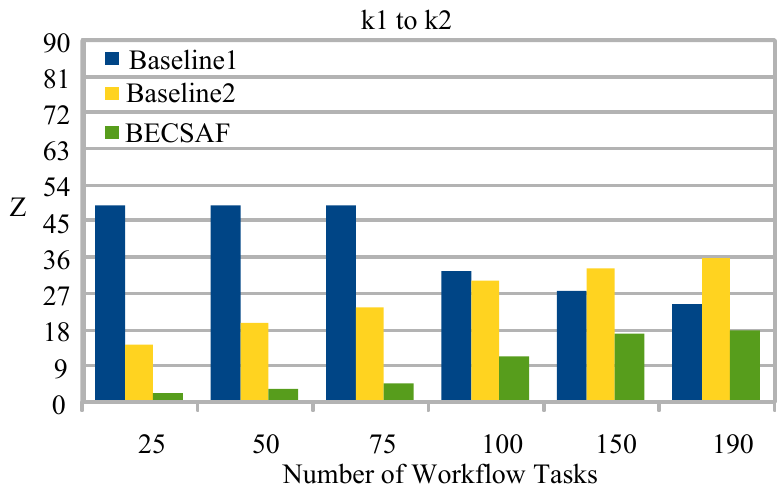
Figure 7. Cost of Failure Between Fog Node k 1 to k 2 During Data Travelling.